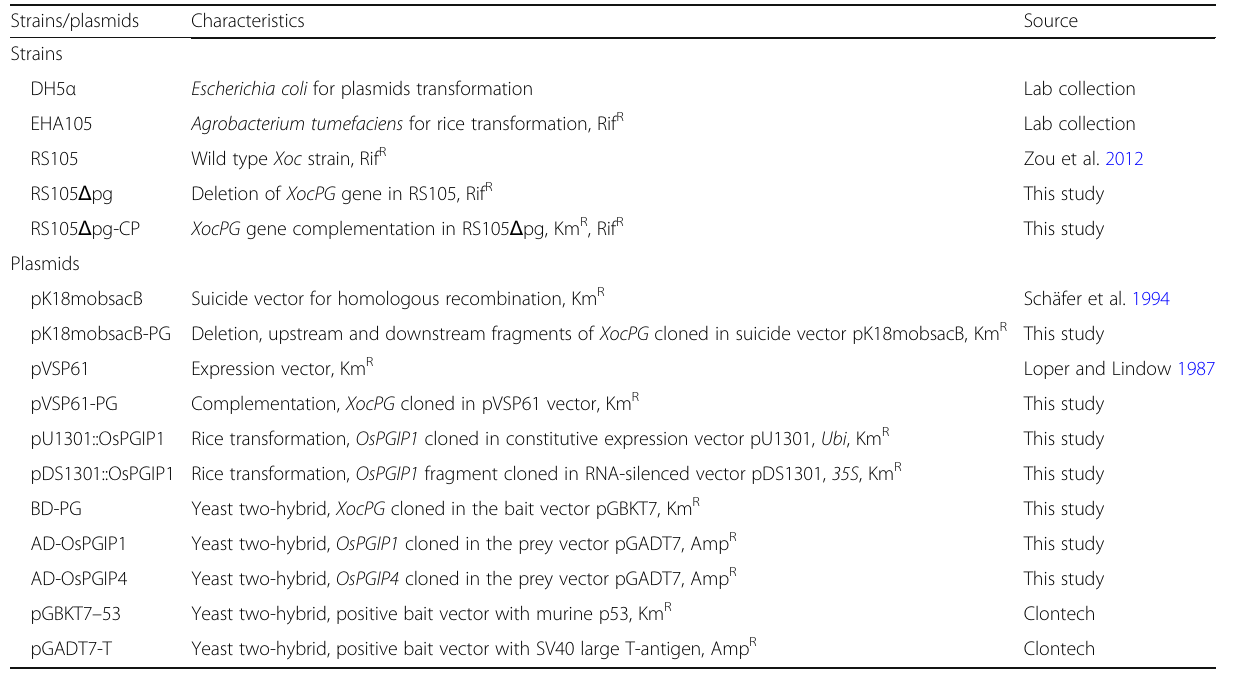
Table 1 Bacterial strains and plasmids Strains/plasmids